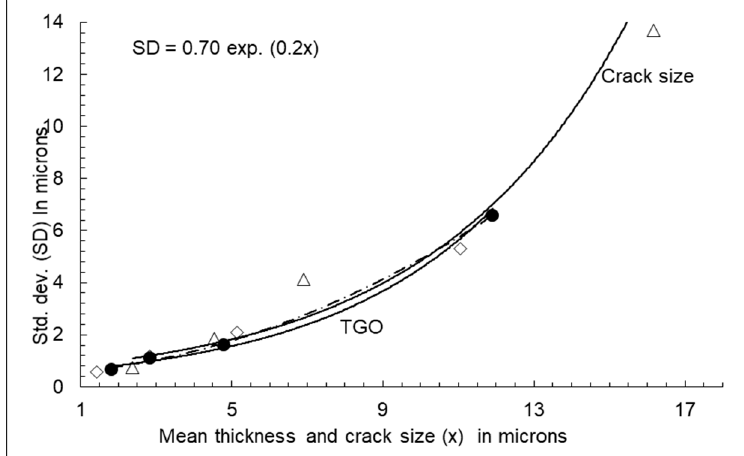
Figure 3. Standard deviation and mean for TGO thickness and crack length data for all samples. Symbol ∆ represents crack length-SD data for M08 samples; symbol • represents TGO-SD data for M07 samples; and symbol ◊ represents TGO-SD data for M08 samples.